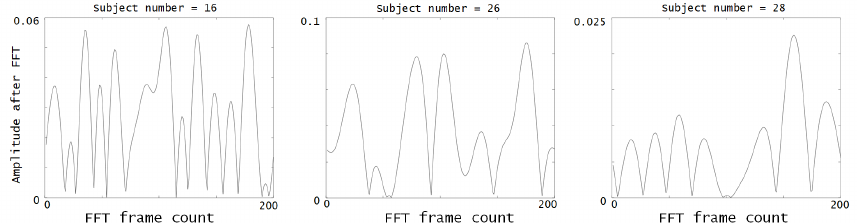
Figure 2. The waveform expresses a dynamic habit that includes several performed activities of user. These are examples, and the input data is in Section 4. A detailed explanation of the numerical representation is in Section 3. Note, these signals indicated positive forms because the negative part of signals inverted to